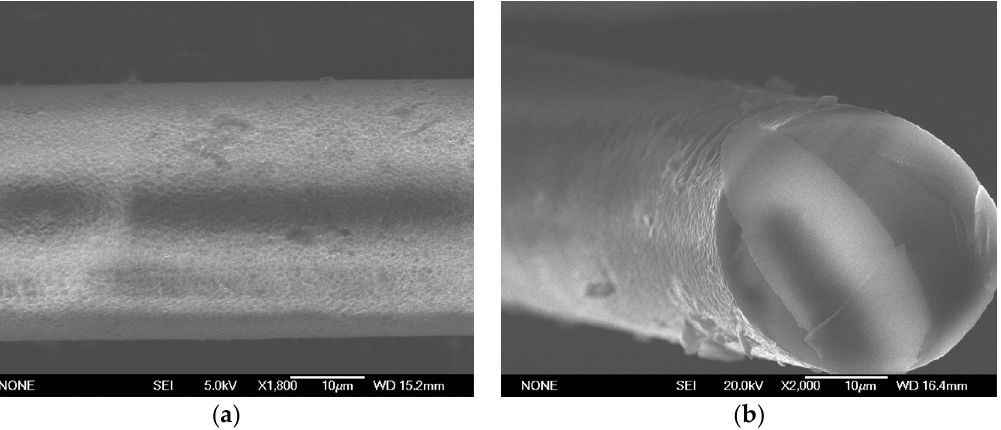
Figure 4. SEM image of the GO deposit on a DLUWT, for an immersion time of 10 min. ( a ) Front view; ( b ) slanted view. The scale and the magnification are shown in the figures (magnifications are ×1800 in ( a ) and ×2000 in ( b )). The texture associated to the GO deposit can be barely seen because of the presence of the previous deposits of the DLUWT.